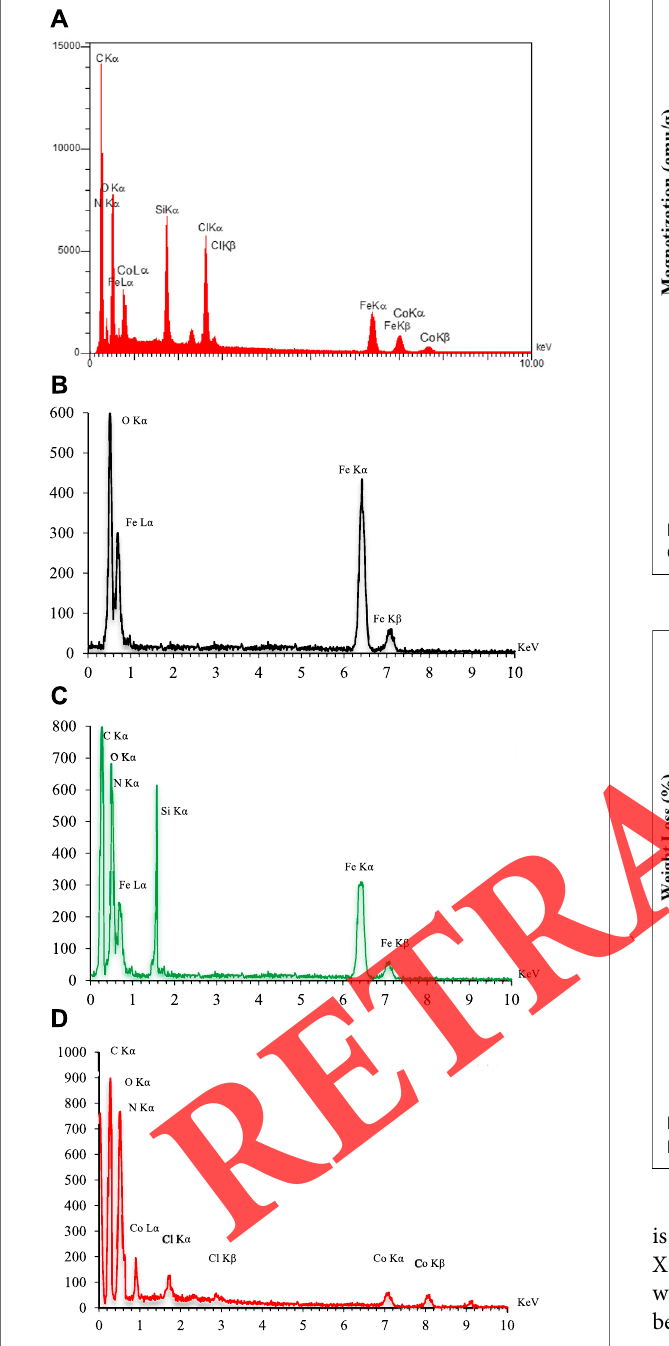
FIGURE 4 | EDS analysis of (A) Fe 3 O 4 @CNF ∼ ImSBL ∼ Co., (B) Fe 3 O 4 , (C) Fe 3 O 4 @CNF ∼ Im, (D) SBL ∼ Co.